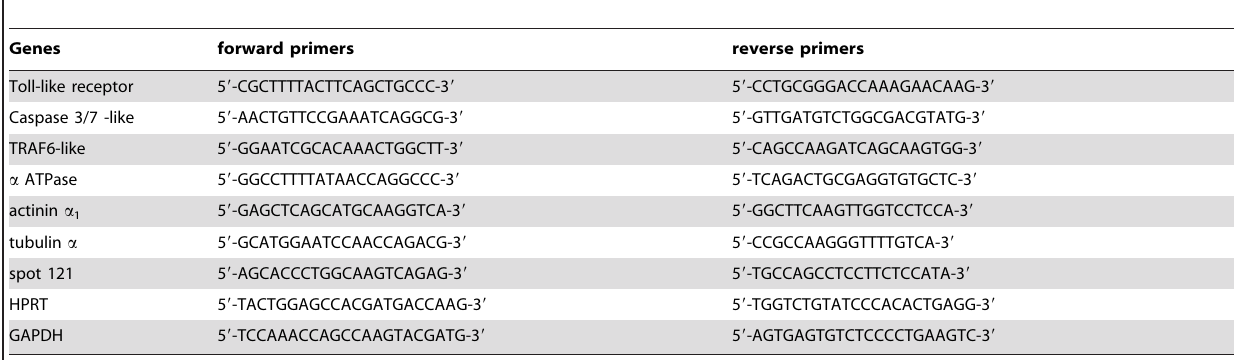
Table 2. Primers used to quantify gene expression in Suberites domuncula using real-time PCR.